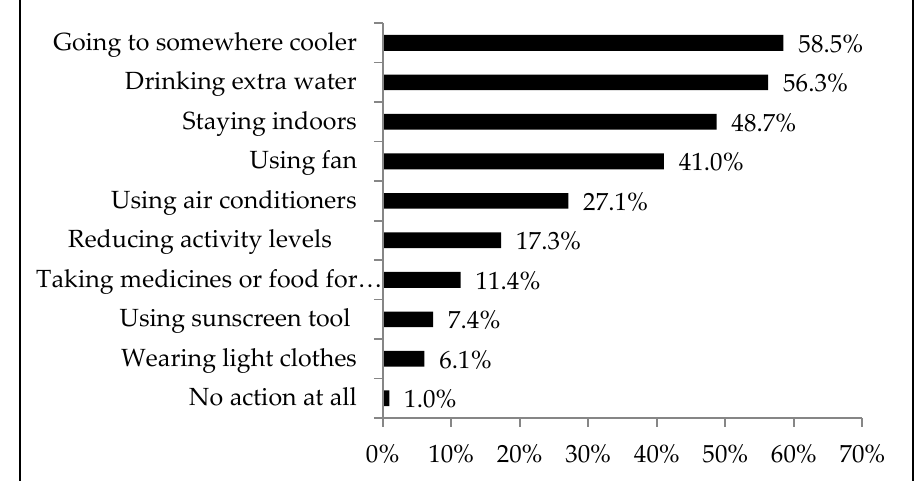
Figure 2. Choices of the participants’ coping behaviors during hot weather.